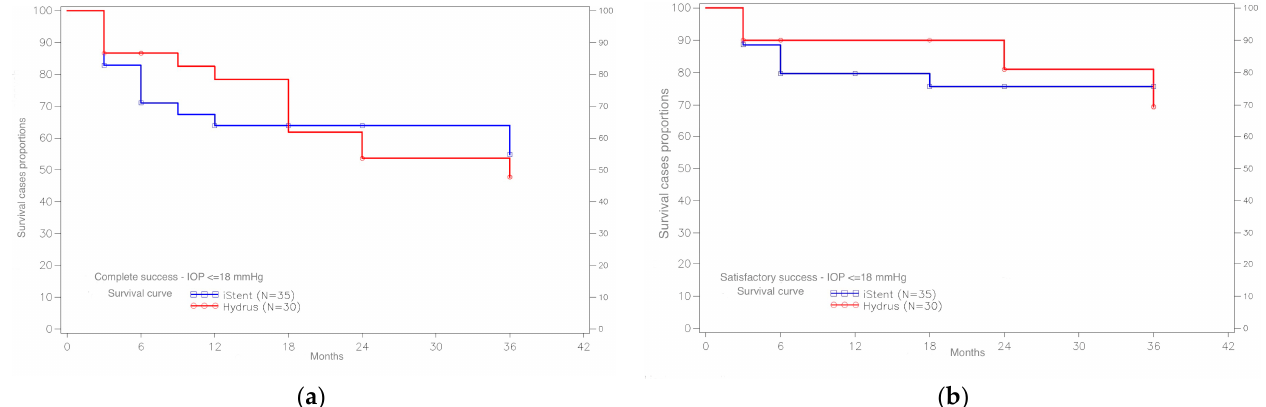
Figure 4. ( a ) Distribution of survival curves for complete surgical success for the IOP criterion ≤ 18 mmHg, for the Hydrus and iStent , and ( b ) distribution of survival curves for satisfactory surgical success for the IOP criterion ≤ 18 mmHg, for the Hydrus and the iStent. For the IOP criterion ≤ 15 mmHg, complete surgical success was achieved after 12 months in 43.1% of cases in the Hydrus group and 44.6% of cases in the iStent group, and after 24 months—in 23.5% of cases in the Hydrus group and 40.1% from the iStent group. Analyzing the course of survival curves for the IOP ≤ 15 mmHg, we see that in the first months after surgery, we have a higher percentage of patients for the Hydrus method than the iStent method with an IOP not exceeding 15 mmHg, without the need for antiglaucoma medications. Nevertheless, with the passage of time after surgery, this trend changes in favor of the iStent method (Figure 5).